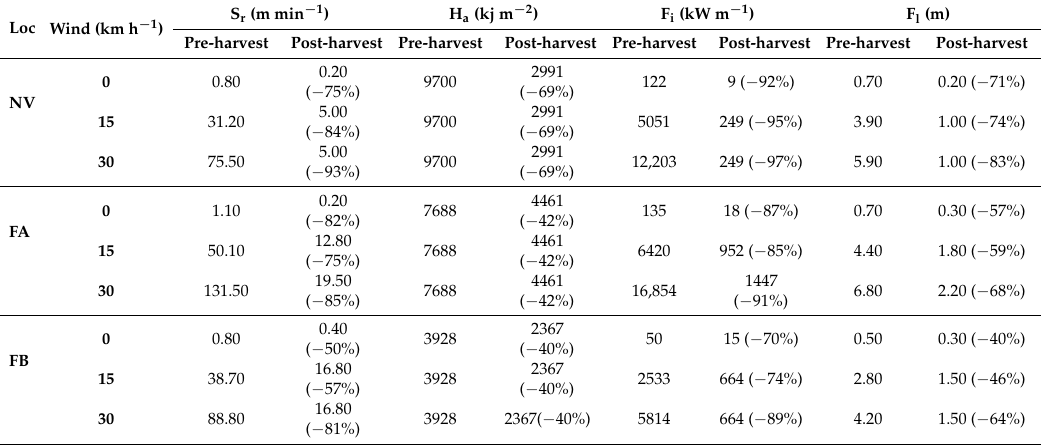
Table 7. Fire behavior variables simulated under three possible wind scenarios (0, 15, and 30 km h − 1 ) before harvesting (year 2015) and two years after harvesting (year